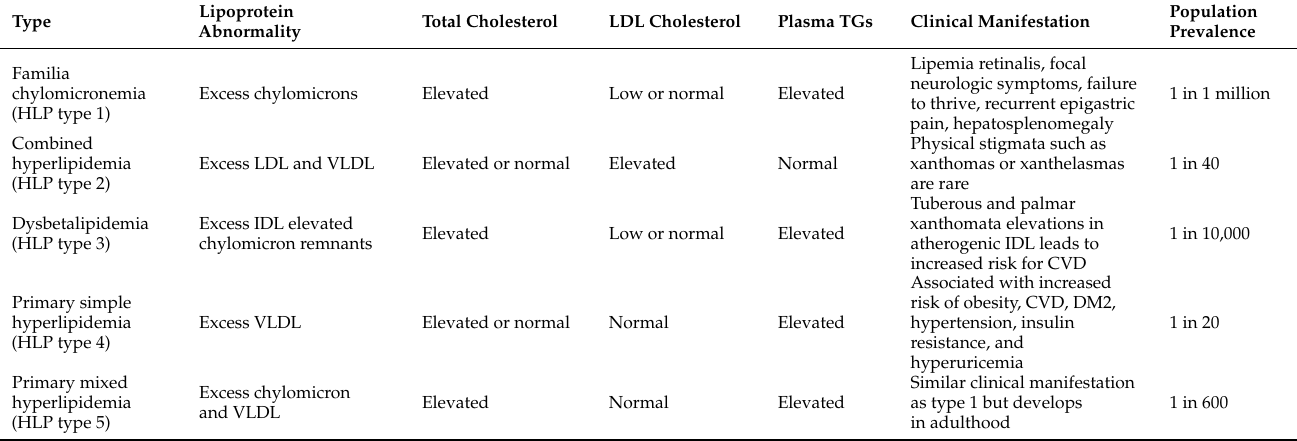
Table 1. Classification of hyperlipidemia 1